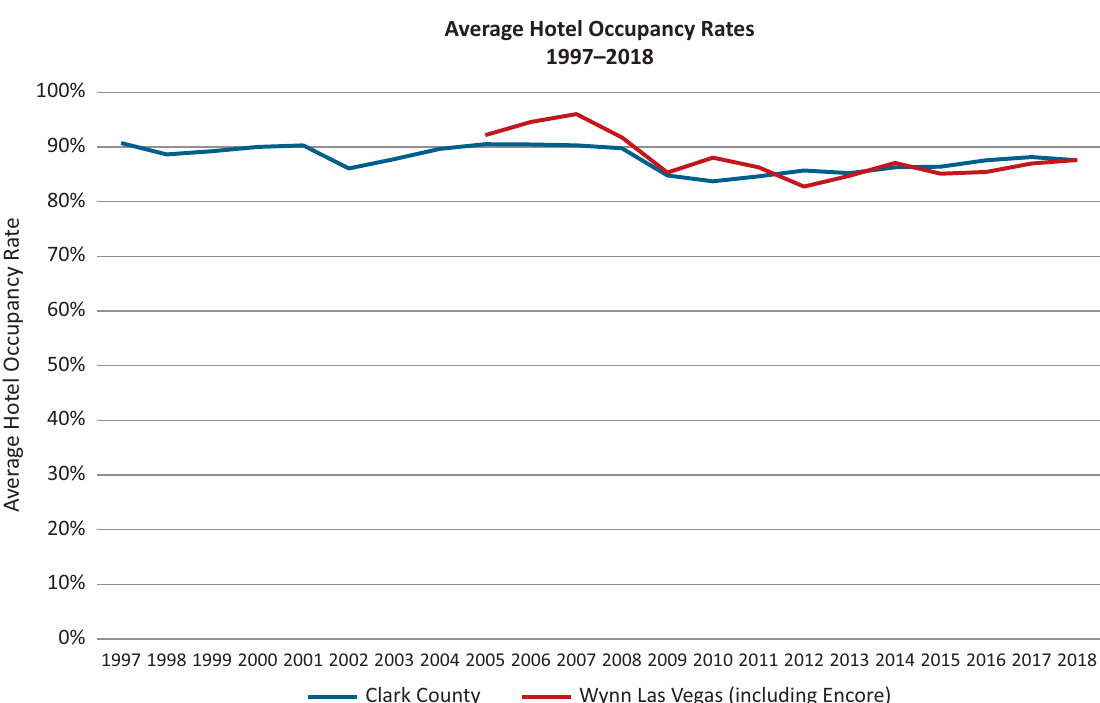
Figure 10. Average hotel occupancy rates in Wynn Las Vegas, compared to average in Clark County (for hotels with gam‐ bling revenue of $1 million and over). Sources: Nevada State Gaming Control Board (1997–2018) and Wynn Resorts Limited